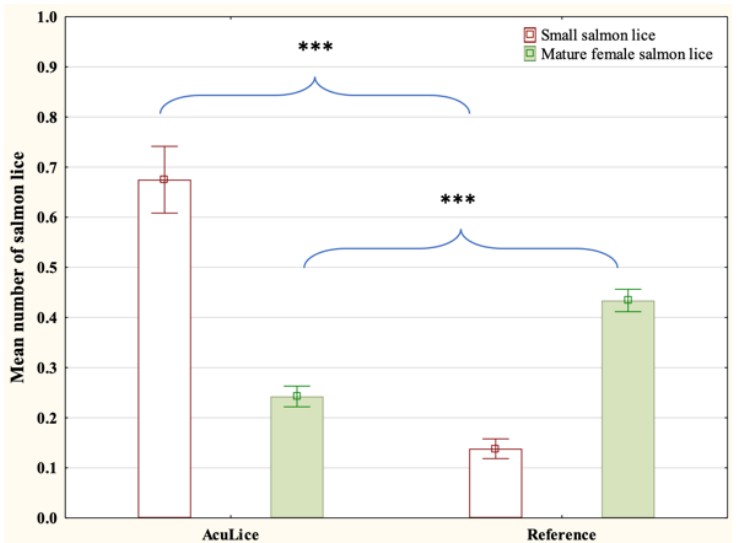
Figure 7. Mean number of small salmon lice (red columns) and mature female lice (green columns) measured per Atlantic salmon between groups exposed to AcuLice treatment compared to the reference group during the period of mid-summer 2019 to late-spring 2020. Asterisks indicate the level of significance between the two groups: *** p < 0.001. Data from each treatment group is presented as a mean ± SEM (N = 60 – 120).